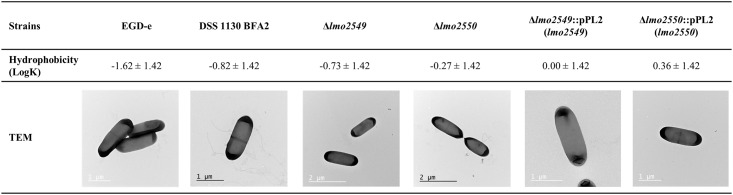
Cell surface characterization of L. monocytogenes with the hydrophobicity (Log K) (n = 3) and observations by transmission electron microscopy of wild-type EGD-e strain cells, DSS 1130 BFA2, EGD-eΔlmo2549, EGD-eΔlmo2550 mutants and the complemented mutants EGD-e Δlmo2549:: pLIV2(lmo2549) and EGD-e Δlmo2550:: pLIV2(lmo2550).